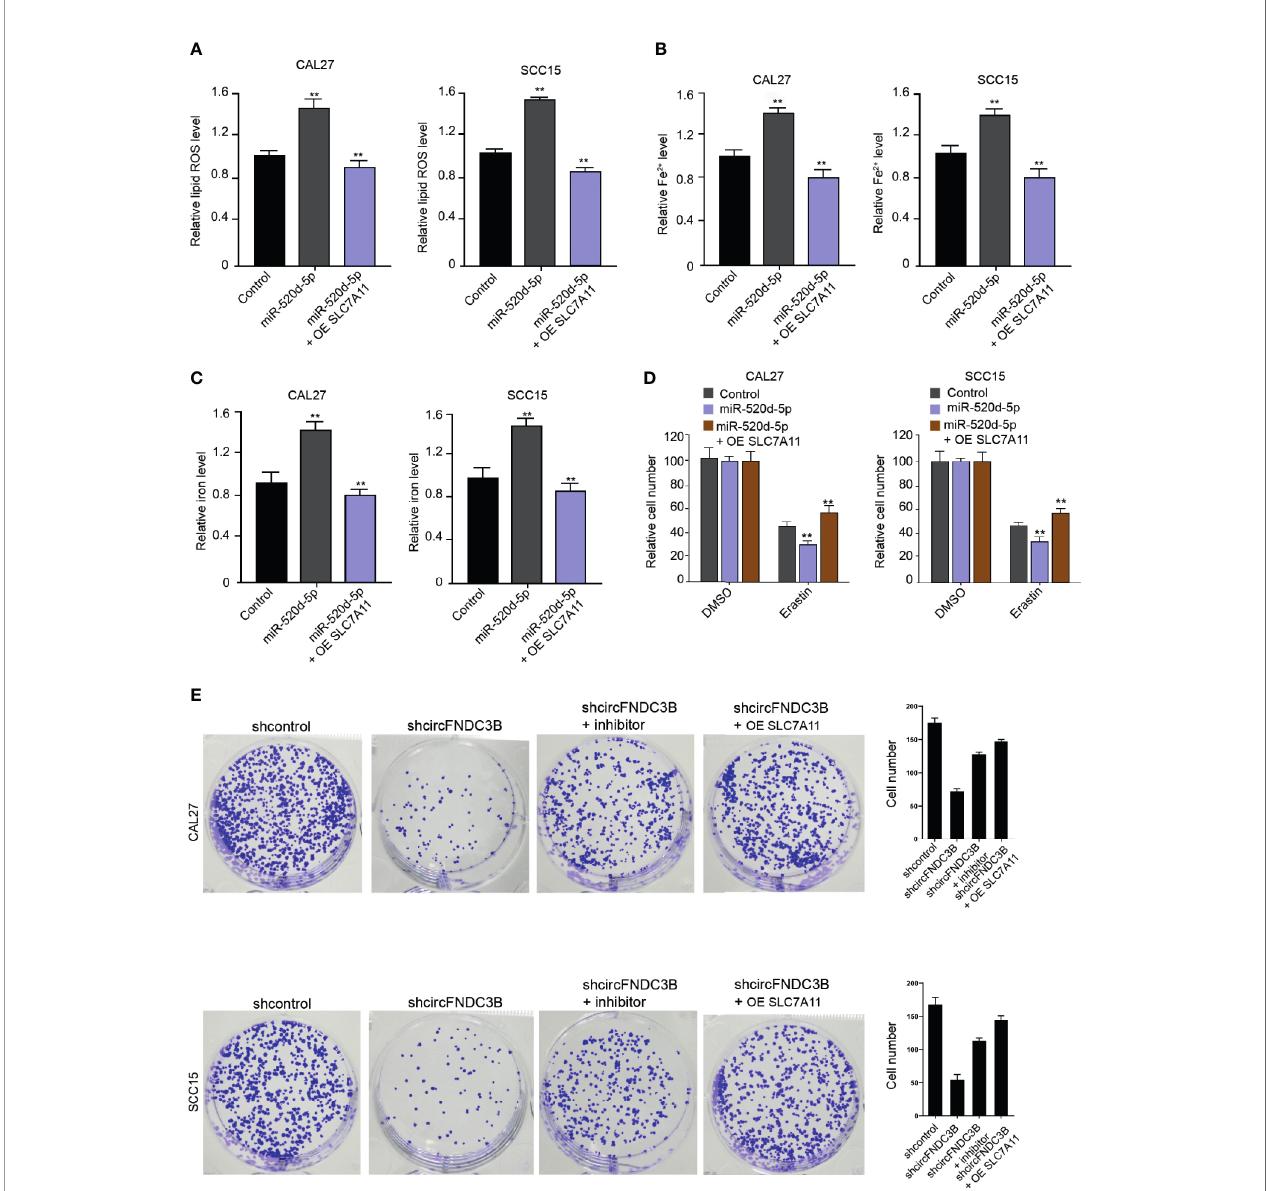
FIGURE 6 | miR-520d-5p induces ferroptosis of OSCC cells by repressing SLC7A11 expression. (A – E) The miR-520d-5p mimic and pcDNA3.1-SLC7A11 were applied to co-treat CAL27 and SCC15 cells. (A – C) Analysis of ROS, iron, and Fe 2+ levels. (D) CCK-8 assays of cell viability. (E) The CAL27 and SCC15 cells were treated with circFNDC3B shRNA or co-treated with circFNDC3B shRNA and miR-520d-5p inhibitor and pcDNA3.1-SLC7A11. Colony formation assays of cell proliferation. N = 3, mean ± SEM: ** P <